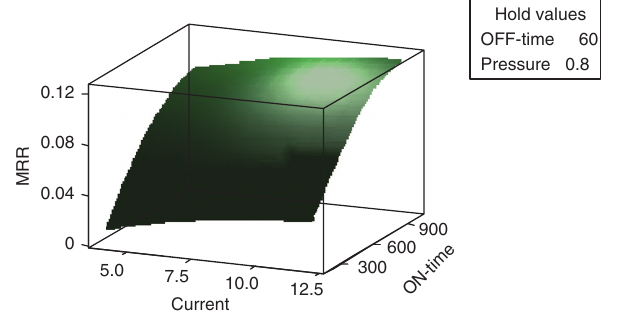
Figure 10 Crack formation on the electrical discharge machined workpiece.